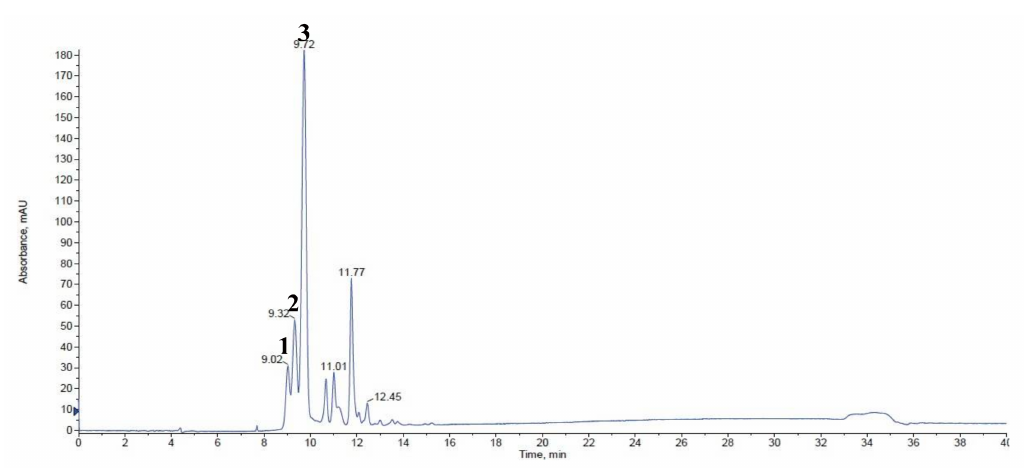
Figure 2. LC-MS TIC spectrum of anthocyanins in red flowers of Rhododendron schlippenbachii . Peak Identification: 1, cyanidin-3,5-diglucoside; 2, cyanidin-3,5-diglucoside; 3, cyanidin-3-sambubioside, Refer to Table 1 for the identification of each numbered